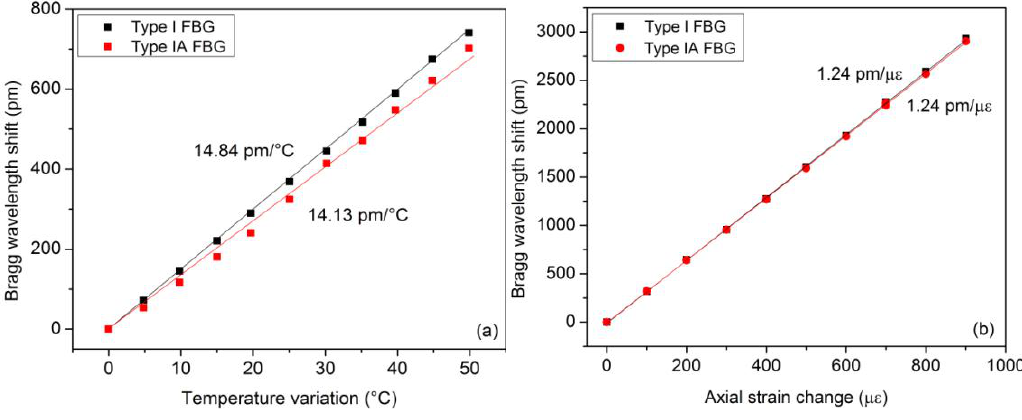
Figure 4. Bragg wavelength shifts of both grating types as a function of strain and